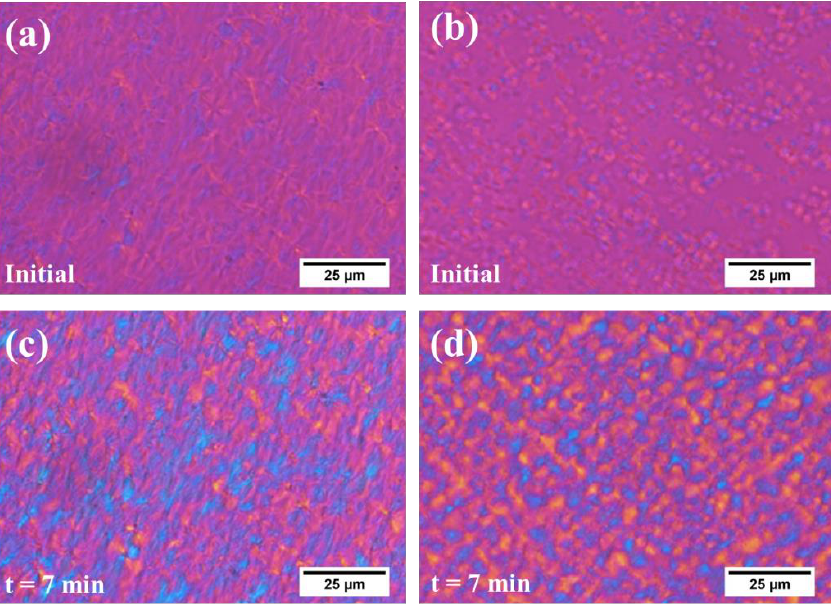
Figure 6. The polarized optical microscopy (POM) during isothermal crystallization: ( a ) PA6, initial crystallization at 200 °C. ( b ) PA6-10, initial crystallization at 115 °C. ( c ) Neat PA6, after 7 min at 200 °C. ( d ) PA6-10, after 7 min at 115 °C.